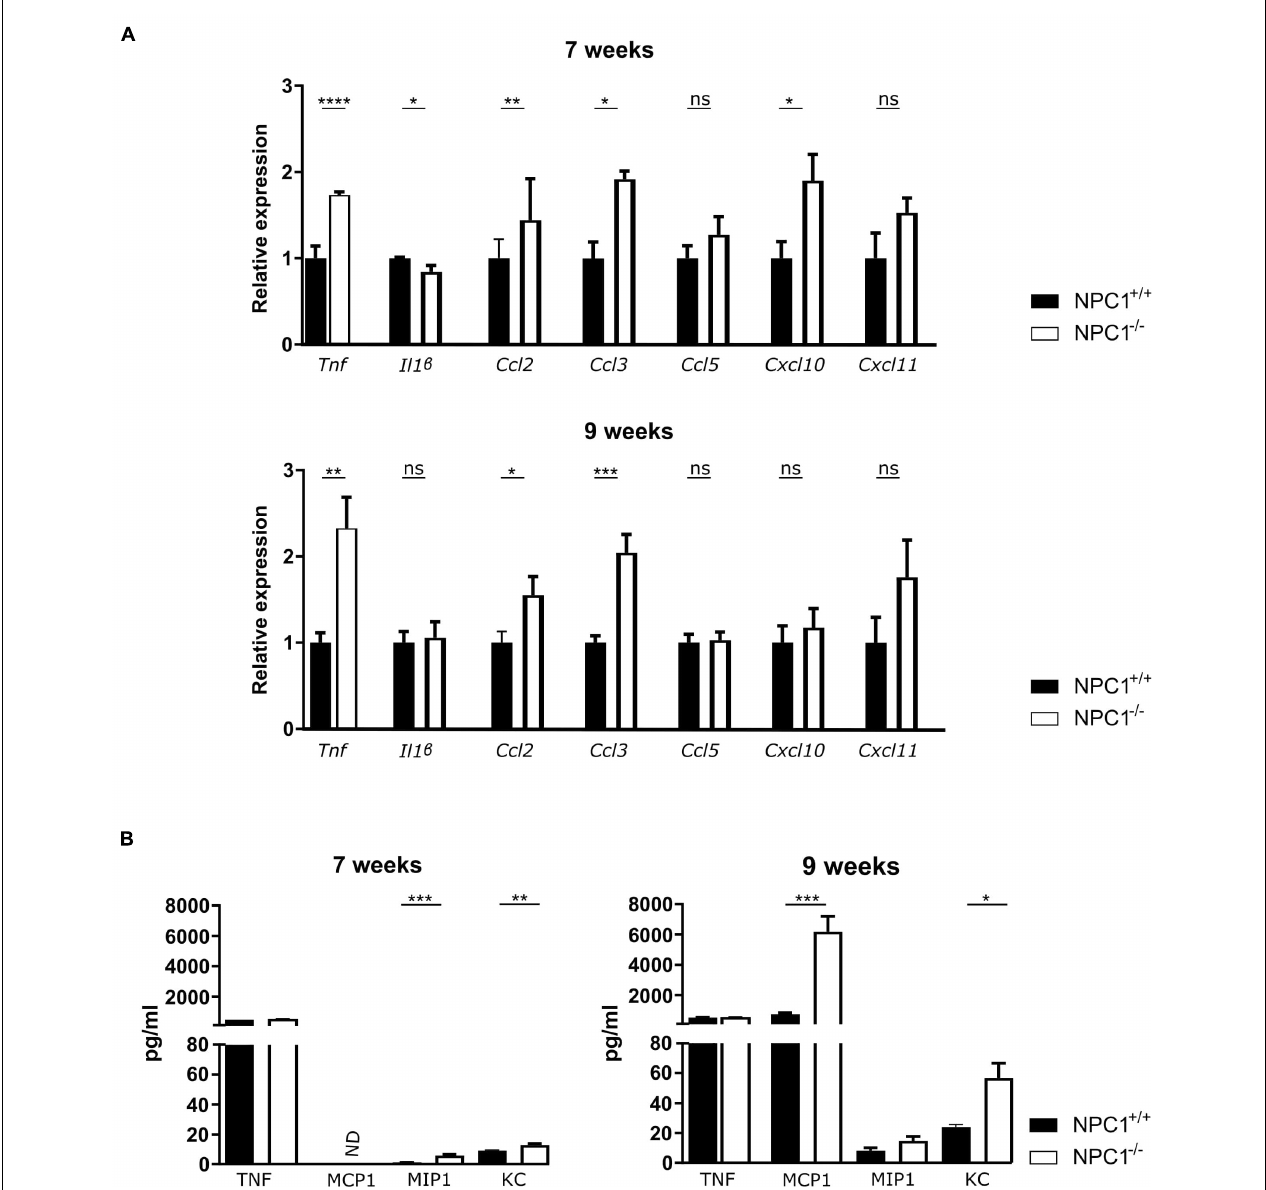
FIGURE 1 | Increased cytokine and chemokine levels in the choroid plexus and CSF of NPC1 − / − mice. (A) qRT-PCR analysis of choroid plexus isolated from NPC1 + / + ( n = 11; black) and NPC1 − / − ( n = 13; white) of 7 and 9 weeks old mice. Results are represented relative to the NPC1 + / + condition. (B) Bioplex analysis of protein levels in CSF from NPC1 + / + (black) and NPC1 − / − (white) mice ( n = 5). Data are shown as mean ± SEM. Statistical analyses on datasets were performed by Mann–Whitney test. Asterisks indicate statistical significance (* p < 0.05, ** p < 0.01, *** p < 0.001, **** p < 0.0001, ns: non-significant). ND: not